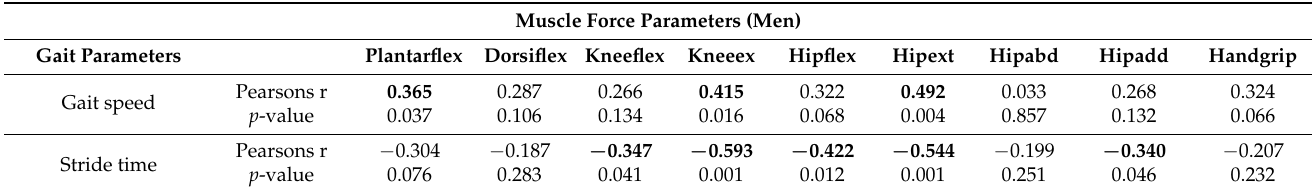
Table 3. Correlations (Pearson’s r) between the strength of lower limbs and gait parameters for men and